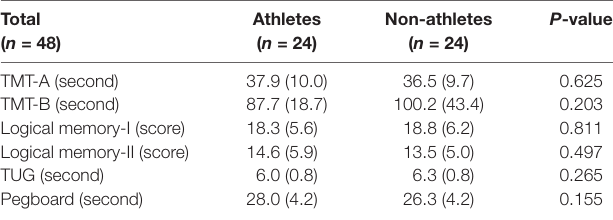
TABLE 3 | Behavioral results in both